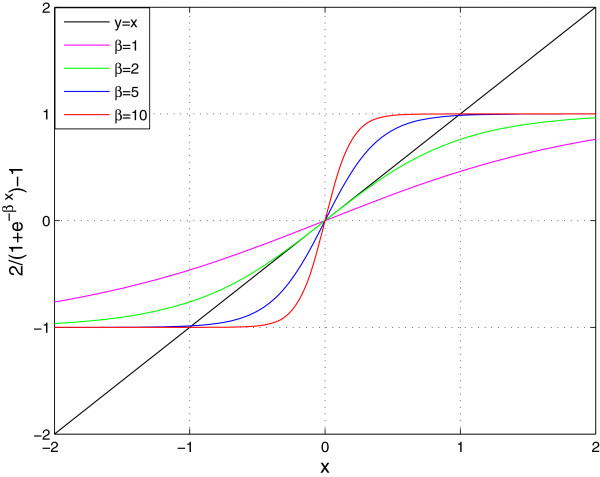
The function
σ

β

(
x
).